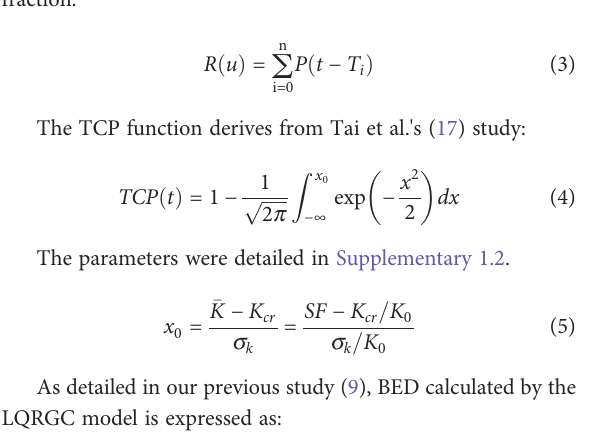
Table 1. There was no signi fi cant difference in